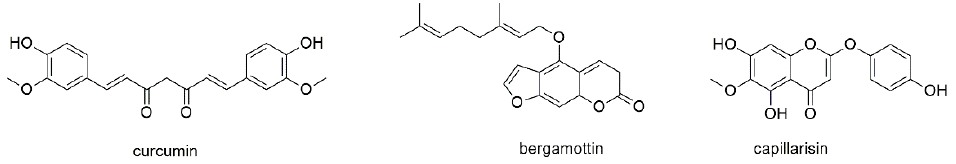
Figure 5. Diarylheptanoids and pyrones with reported activity against myeloma cell lines.